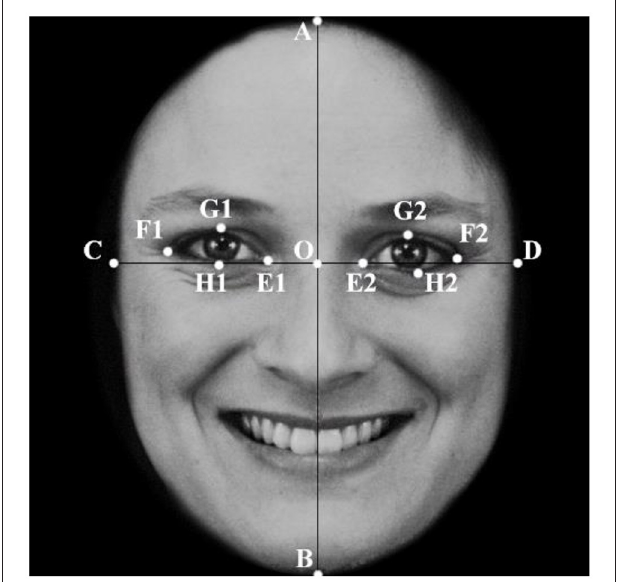
FIGURE 1 | Face ratio measurement method. Using the facial measurement method, a coordinate system is established for the stimuli faces, using the line of the inside of the eye as the X-axis and the midline of the nose as the Y-axis. The intersection of the X-axis and the Y-axis (O), head length (AB), face width (CD), eye width (EF) and length (GH), eye aspect ratio (GH/EF), and eye-to-face length ratio (GH/EF) were